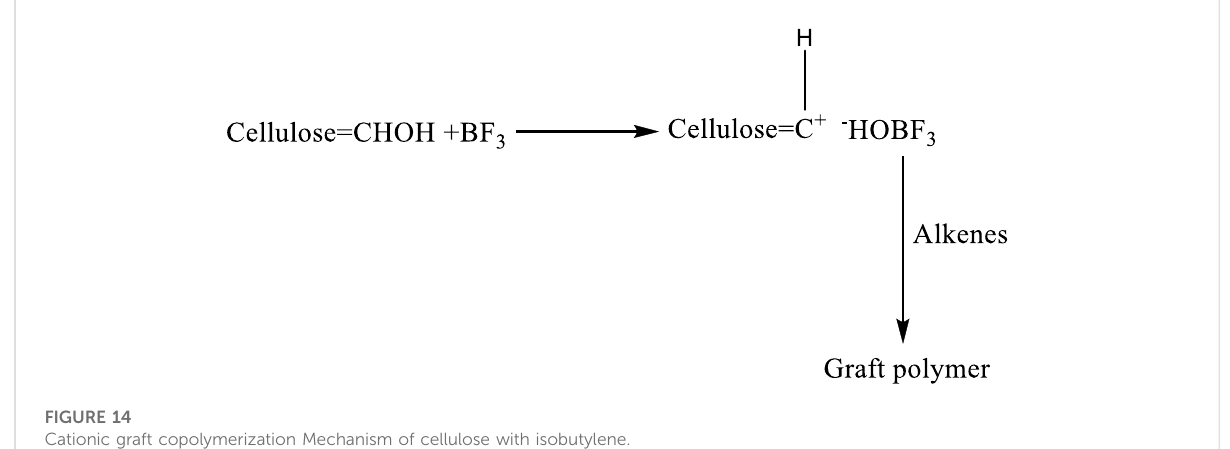
FIGURE 14 Cationic graft copolymerization Mechanism of cellulose with